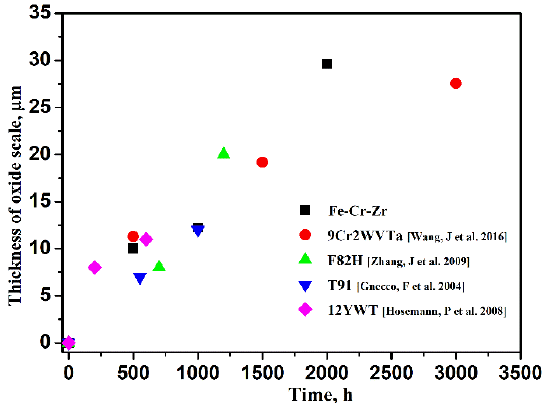
Figure 11. Thickness of oxide scale of Fe-Cr-Zr alloy obtained by oxidation in oxygen-saturated liquid Pb-Bi eutectic at 823 K compared with the ferritic/martensitic steels (Data from [19,34–36]).